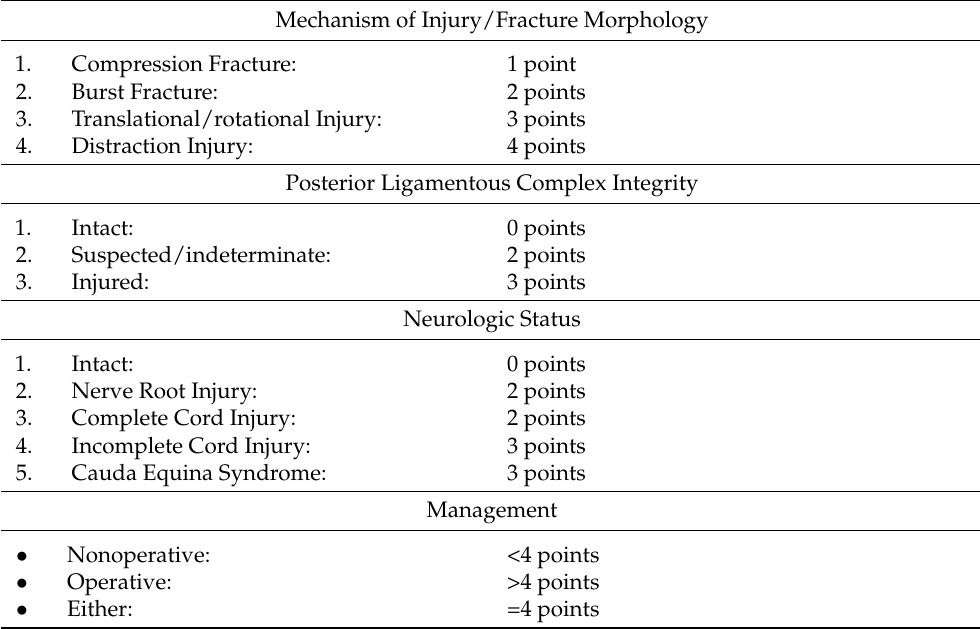
Table 3. Thoracolumbar Injury Classification System